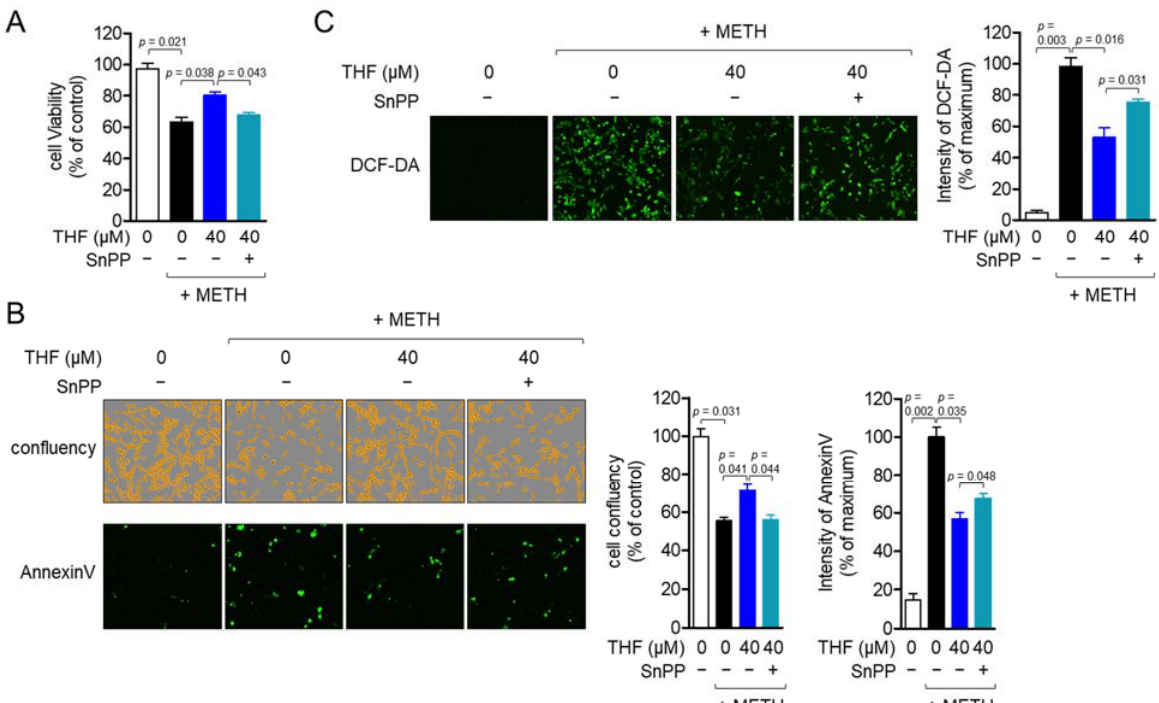
Figure 7. ( A ) SH-SY5y cells were pretreated with 20 μ M tin-protoporphyrin IX (SnPP) for 1 h and then pretreated with 40 μ M THF for an additional 6 h. After pretreatment, the cells were exposed to 2 mM METH for an additional 24 h. The cell viability was assessed by the MTT assay and the percentage of the control was calculated based on the resulting OD value. ( B ) SH-SY5y cells (1 × 10 4 /well, 96-well plate) were stained with 1× annexin V and 1× caspase 3/7 staining reagent and